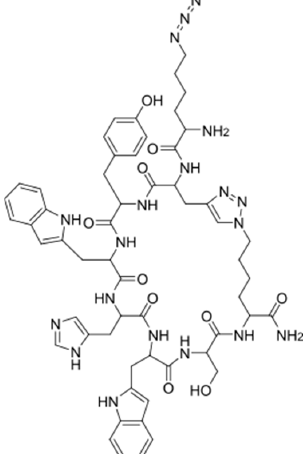
Figure 1. Structure of azide-modified E2-binding peptide.